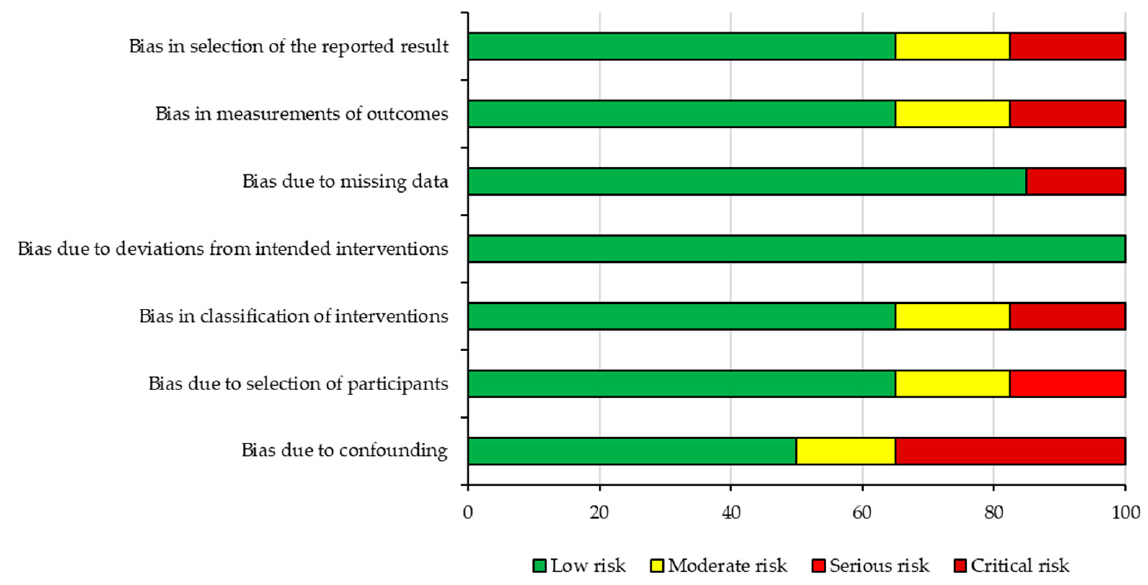
Figure 3. Summary diagram for risk of bias in included